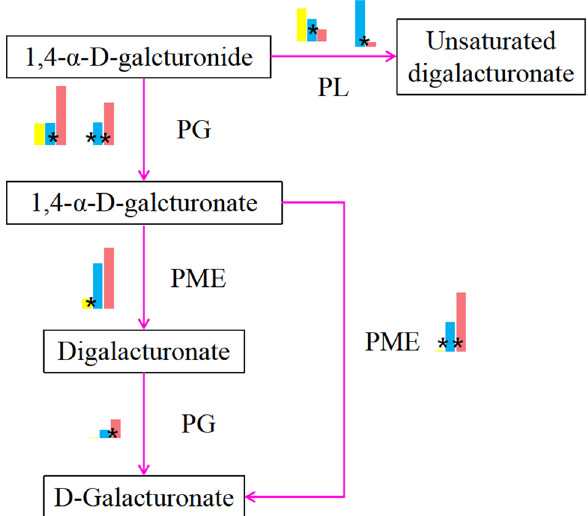
Figure 8. Pectinase metabolism pathway. Note: pink right arrow Pectinase metabolism, yellow square the FPKM of S3, blue square the FPKM of S4, pink square the FPKM of S5.